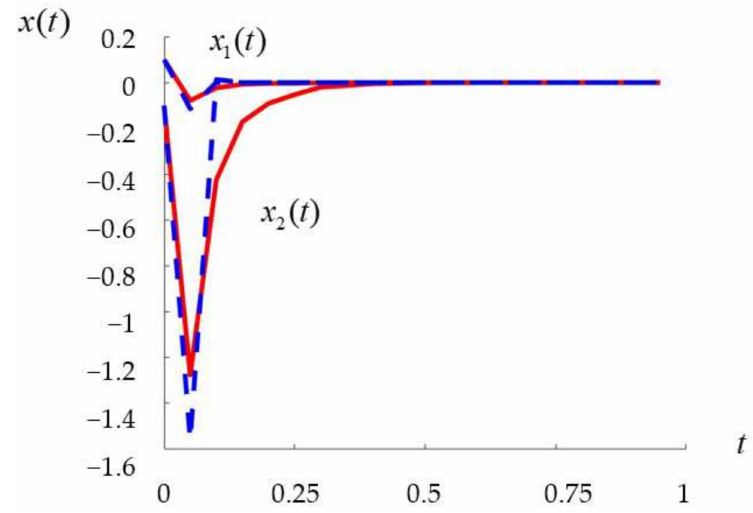
Figure 1. Closed-loop system trajectories: Modified Pad é [1/2] approximation (red lines) and D-SDRE (blue